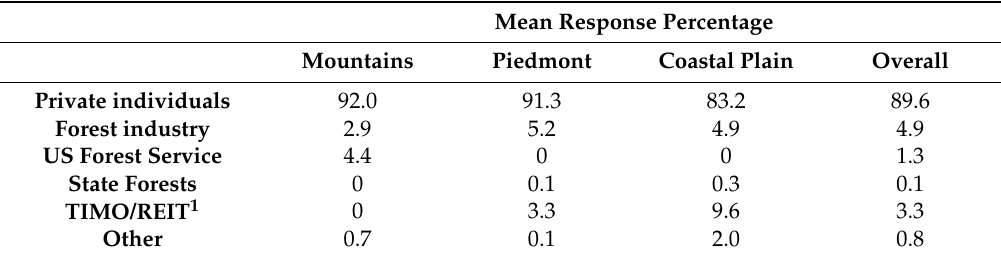
Table 2. Type of land ownership where business owners harvested timber in the past year.